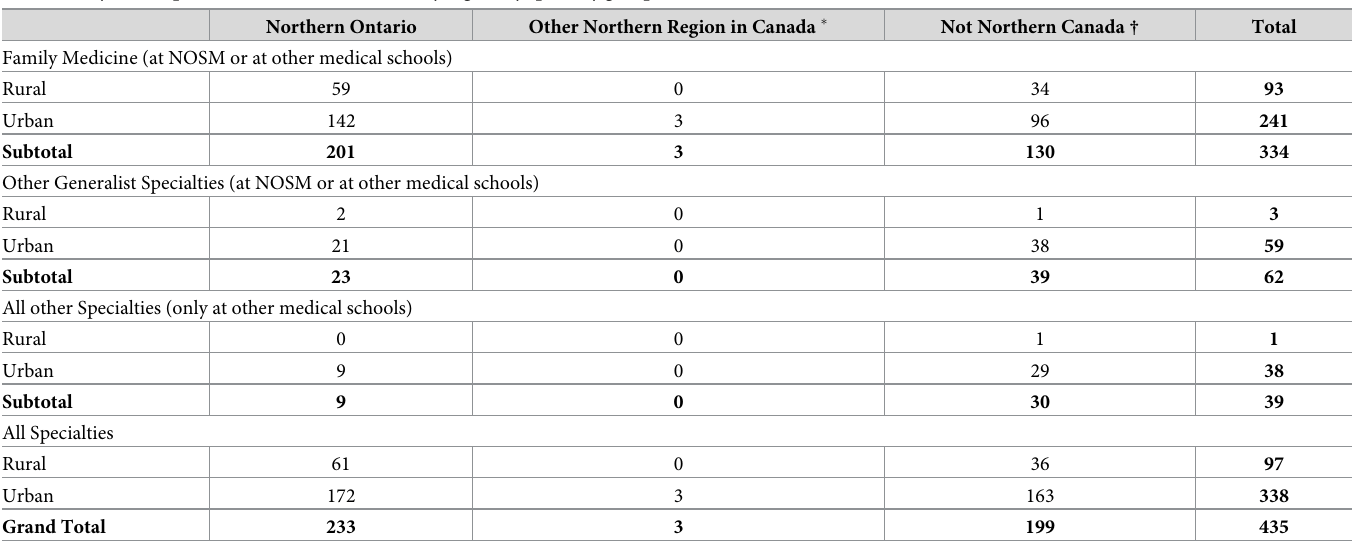
Table 2. Physicians’ practice location: rural/urban by region by specialty group.